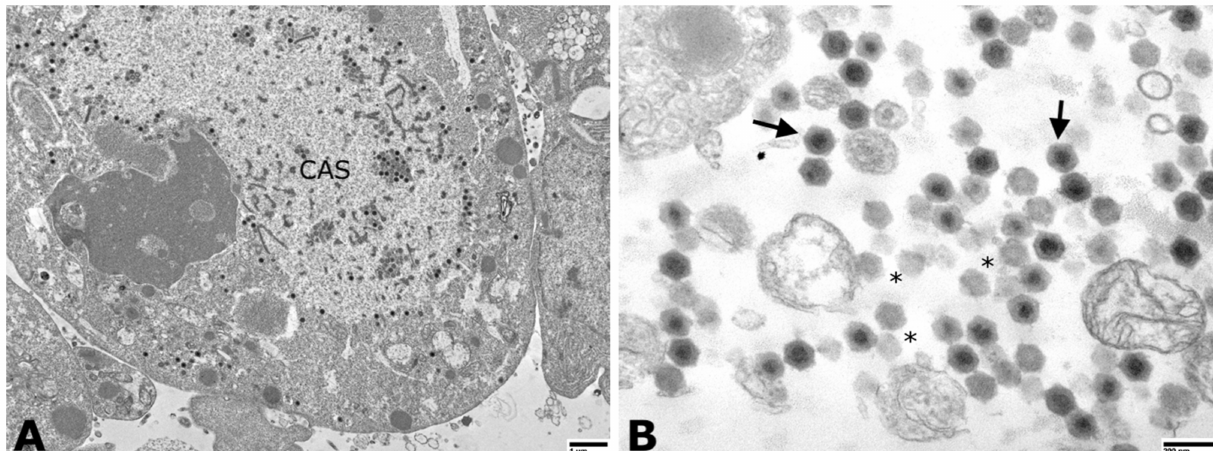
Figure 3. Transmission electron photomicrographs of megalocytivirus-infected OmB cells. ( A ) Virus particles were observed in the cell cytoplasm and within a large cytoplasmic assembly site (CAS). Particles were individualized and formed small paracrystalline arrays (scale bare = 1 µ m). ( B ) Higher magnification image (scale bar = 200 nm) of virions with icosahedral nucleocapsids and electron-dense nucleic acid cores surrounded by a translucent zone and outer nucleocapsid layer (solid arrows). Empty nucleocapsids were scattered throughout (asterisks).